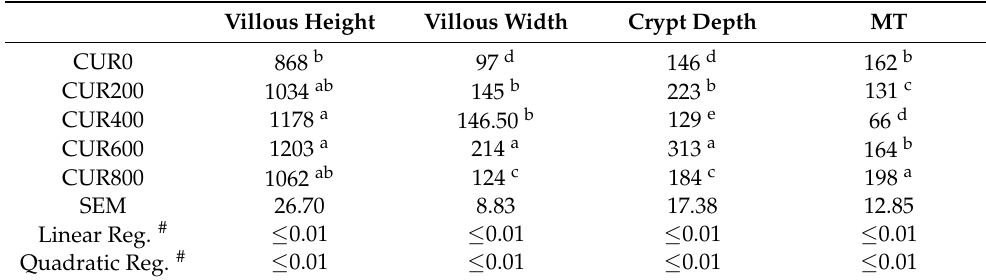
Table 4. The effects of dietary curcumin (CUR) on intestinal histomorphometric measures ( µ m) of O. niloticus . Villous Height Villous Width Crypt Depth MT CUR0 868 b 97 d 146 d CUR200 1034 ab 145 b 223 b 131 c CUR400 1178 a CUR600